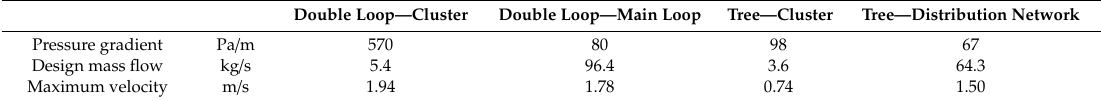
Table 4. Pressure gradient and design mass flow rate for the network. Double Loop—Cluster Double Loop—Main Loop Tree—Cluster